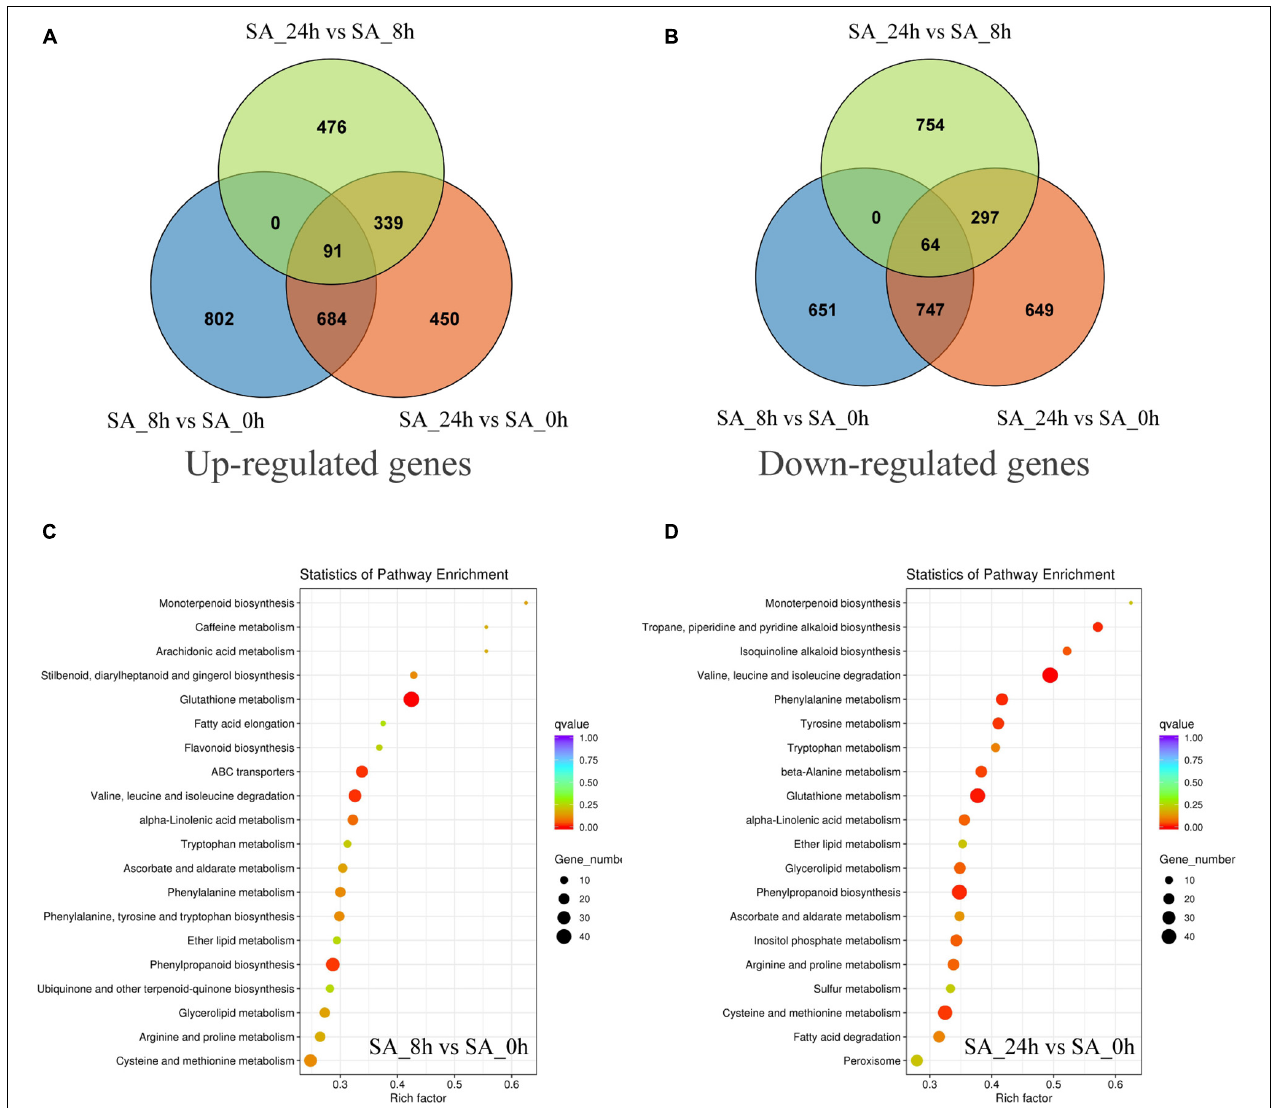
FIGURE 4 | The distribution and classification of differentially expressed genes under SA treatments. (A,B) Venn figures represented the numbers of up-regulated (A) and down-regulated (B) genes in three comparison types (“SA_8h vs. SA_0h,” “SA_24h vs. SA_0h,” and “SA_24h vs. SA_8h”). (C,D) The pathway enrichment analysis of the up-regulated genes involved in “SA_8h vs. SA_0h” (C) or “SA_24h vs. SA_0h” (D) based on KEGG databases.